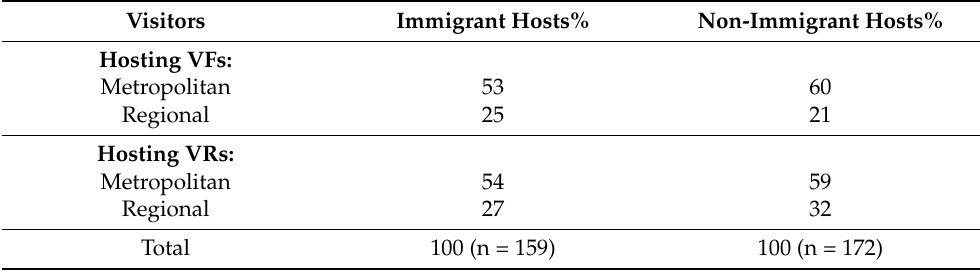
Table 1. Distribution of hosting VFRs among local residents.